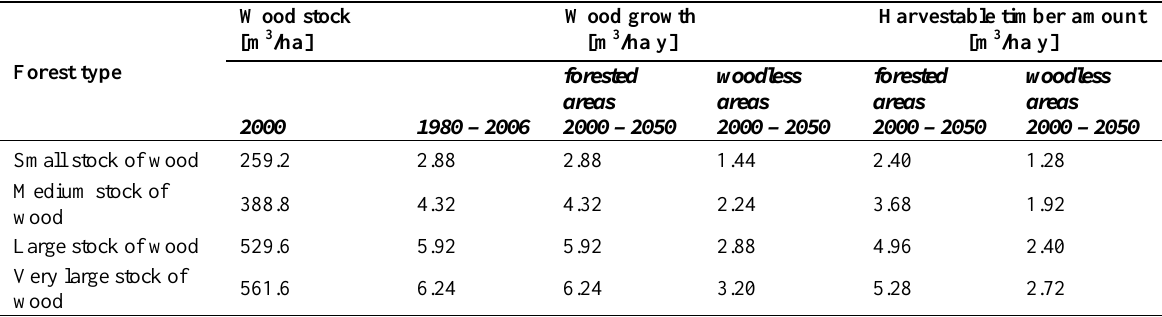
Table A2.1. Stock, annual growth rate and harvestable amount of timber for different forest types in Davos under a trend scenario (based on Grêt-Regamey et al. 2013). We estimated wood growth by allocating the average growth rate of the forest of Davos between 1980 and 2006, which was 4.87 m 3 /ha (LFI 2008), to different forest types proportionally to their stock of wood and assuming a 50% lower growth rate in newly afforested plots (FOEN 2011). In the climate scenario, we increased these growth rates by 1.2 m 3 /ha y accounting for a temperature induced upwards shift of the altitudinal vegetation zones (LFI 2008). The harvestable amount of timber is 15% less than the actual growth volume due to non-merchantable tree